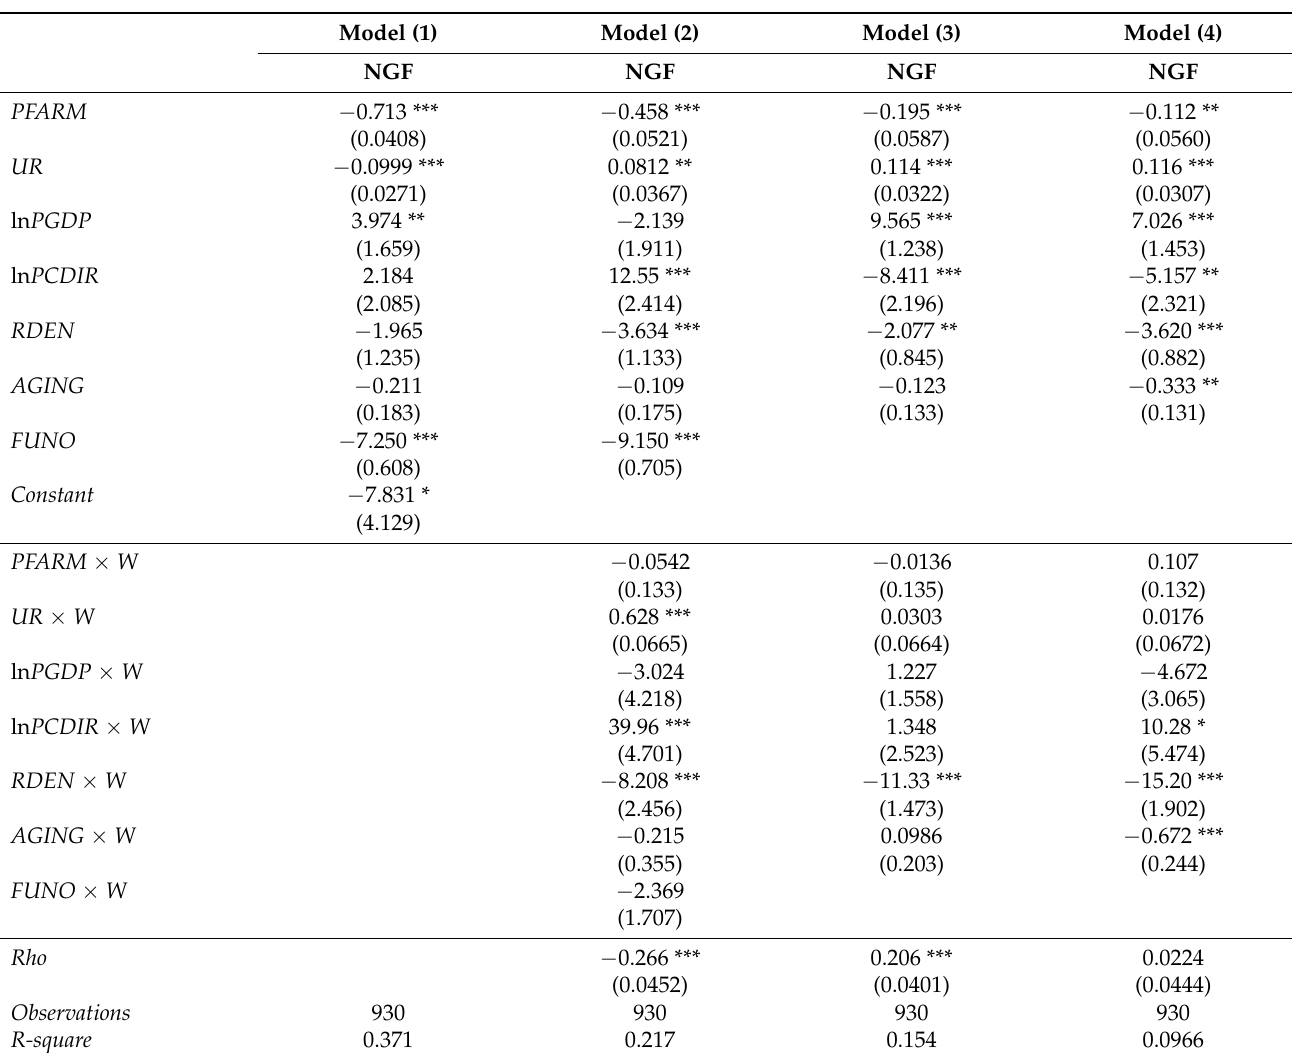
Table 4. SDM estimation of the influencing factors of NGF in